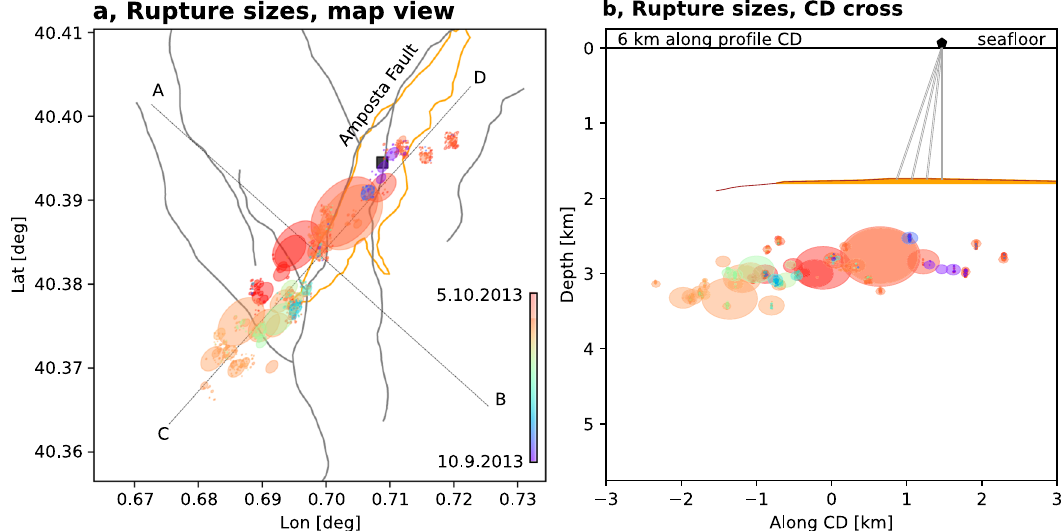
Fig. 8 Temporal evolution of earthquake rupture size. Rupture sizes are shown in map view ( a ) and along CD cross-section ( b ). During the SW migration in phases 1 and 2, which accompanies the spatial extension of the injected gas volume within the NE – SW oriented reservoir, the seismicity rate is discontinuous and small-size earthquakes alternate with short periods of quiescence, leaving large unbroken patches. These are fi lled by larger earthquakes occurring during phase 3, when seismicity migrates backwards. We assume circular rupture areas, with sizes plotted according to a crack model for a fi xed stress drop of 3 MPa, and color denoting origin time (see color bar in a ). Seismicity and locations are from the catalog based on join relocation and template matching, as in Fig. 7. Small, random location shifts have been applied for events below magnitude 2.5, mostly detected by template matching, to better visualize their overlapping locations. The orange line in a marks the approximate outline of the reservoir at the depth of 1800 m 29 and thus the rough extension of the gas- fi lled volume. A brown line and an orange fi lled region in b sketch the projection of the reservoir roof and gas- fi lled volume along the CD pro fi le, respectively. The Castor platform is marked by a black square in a and a pentagon in b (here gray double lines sketch the path of injection wells) 29